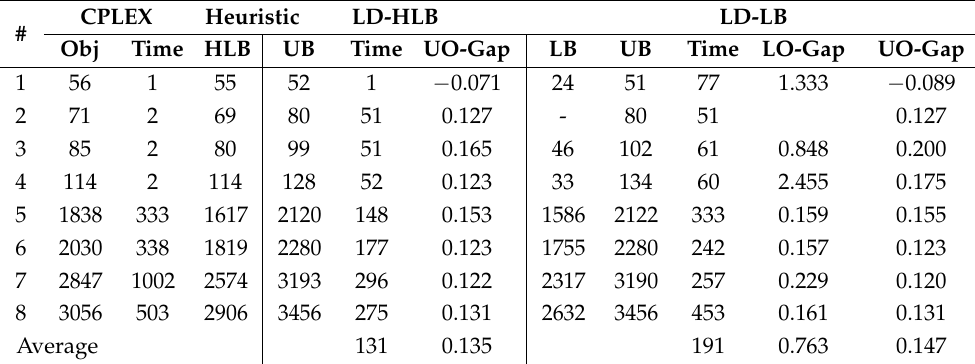
Table 9. Computational results to compare CPLEX and LD for small size